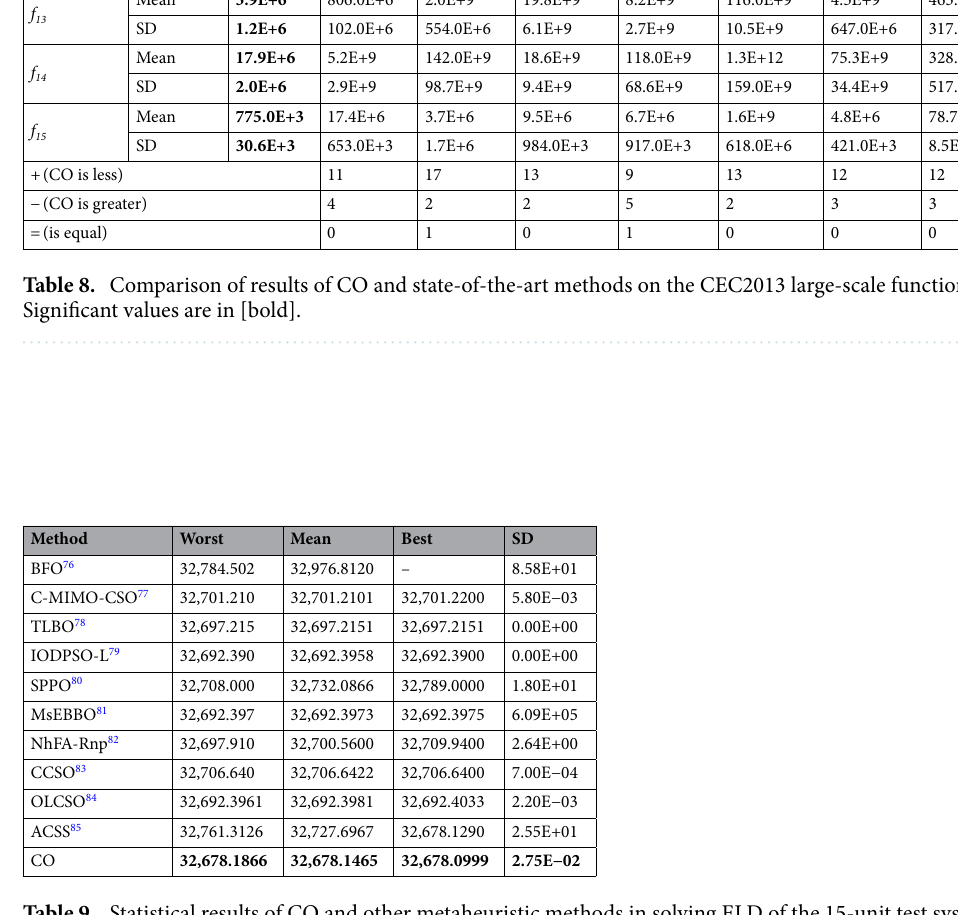
Table 9. Statistical results of CO and other metaheuristic methods in solving ELD of the 15-unit test system. Significant values are in